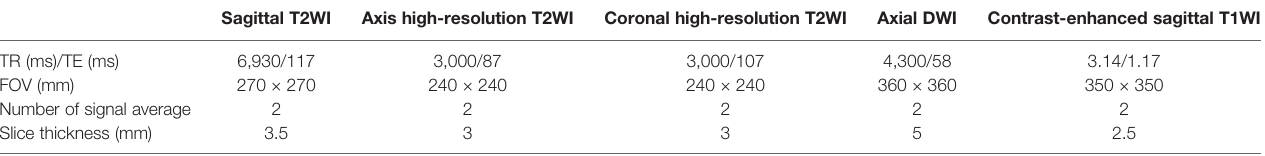
TABLE 1 | MRI protocol for rectal